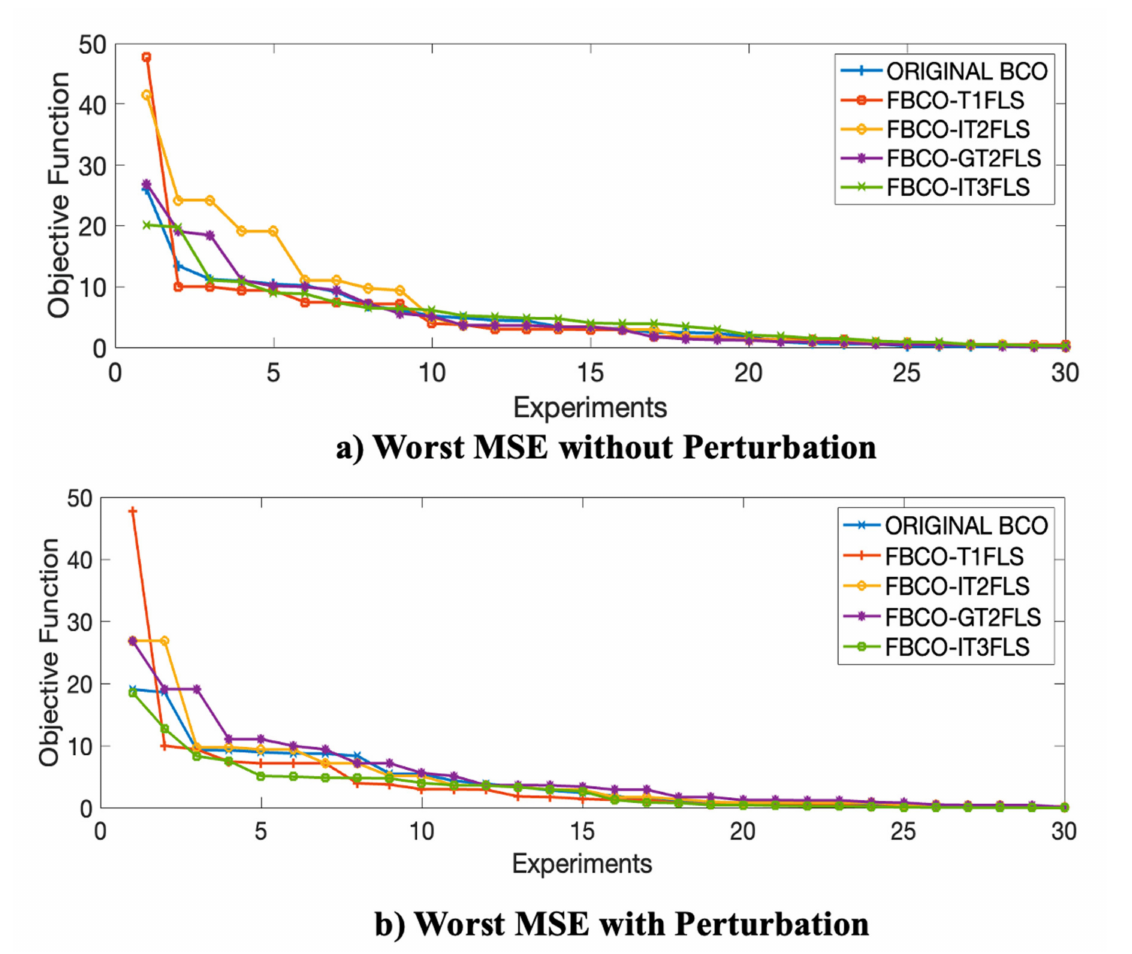
Figure 26. Comparative of the Worst convergence for each Fuzzy Sets and original BCO algorithm, ( a ) with Perturbation and ( b ) with Perturbation in the